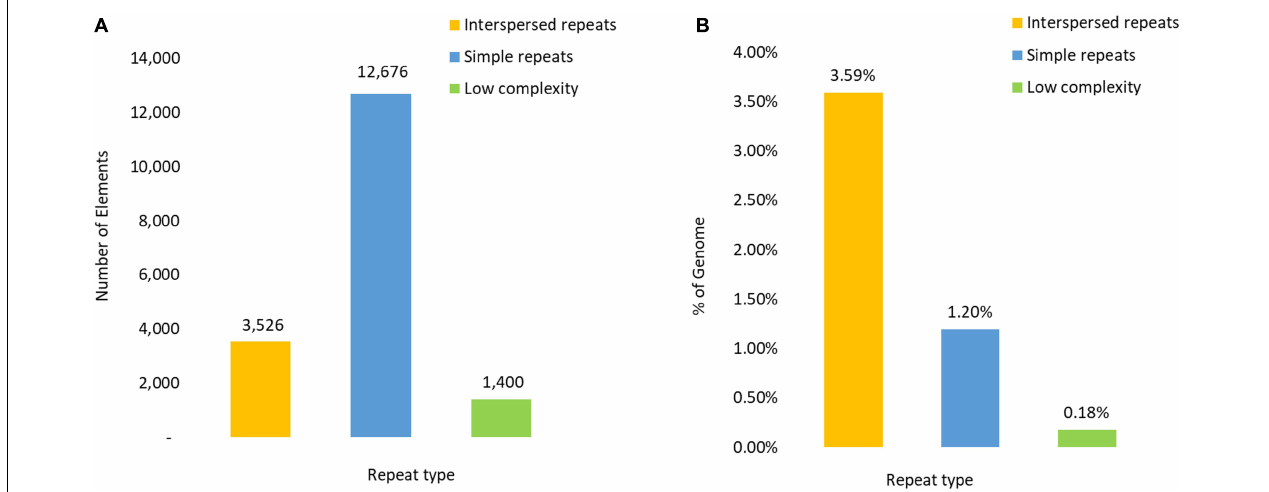
FIGURE 1 | Composition of the Repetitive DNA content reflected in (A) as the number of repeat elements and (B) by the percentage of the genome covered by each repetitive element type.